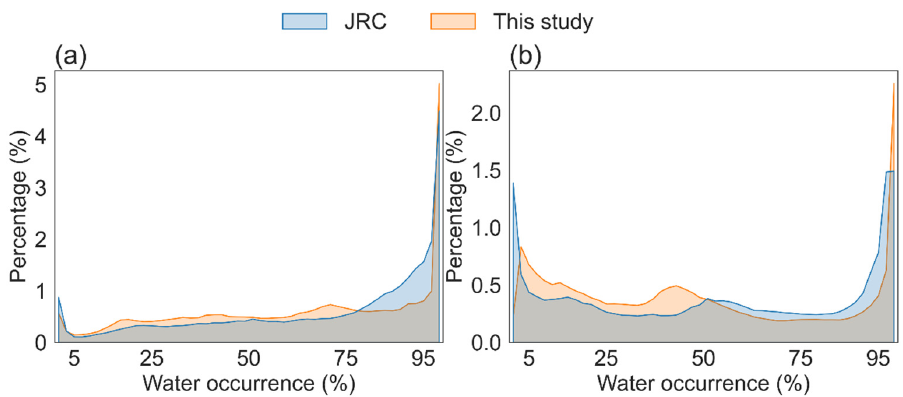
Figure 4. Comparison of water occurrence. ( a , b ) represent Poyang Lake and Dongting Lake, respectively. Here, the water occurrence of this study was calculated for the whole period (1989 to 2020).